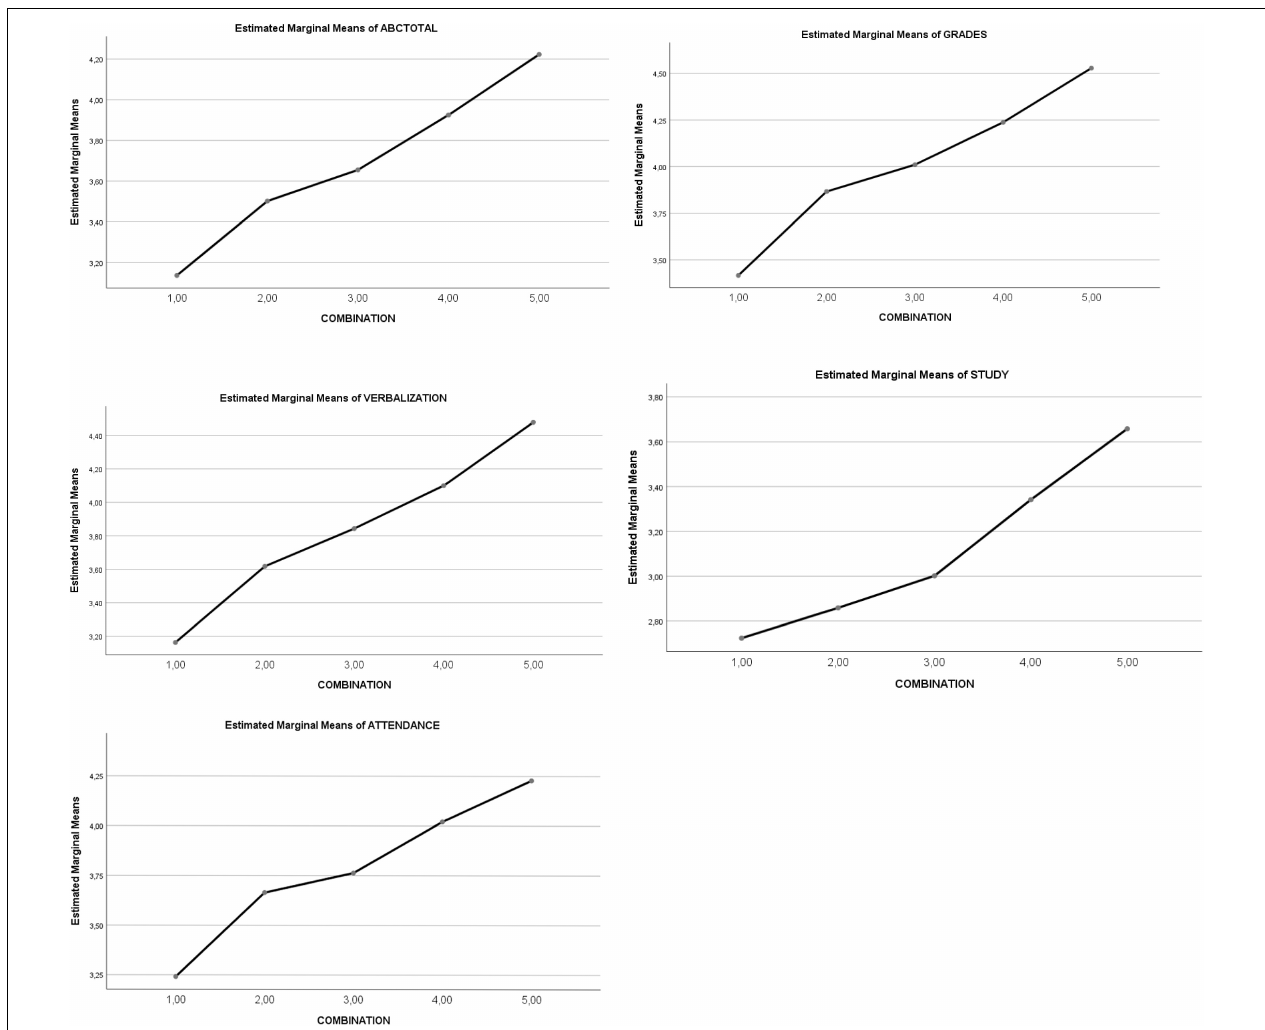
FIGURE 1 | Graphical representation of the effect of combination types (1–5) on Academic Behavioral Confidence